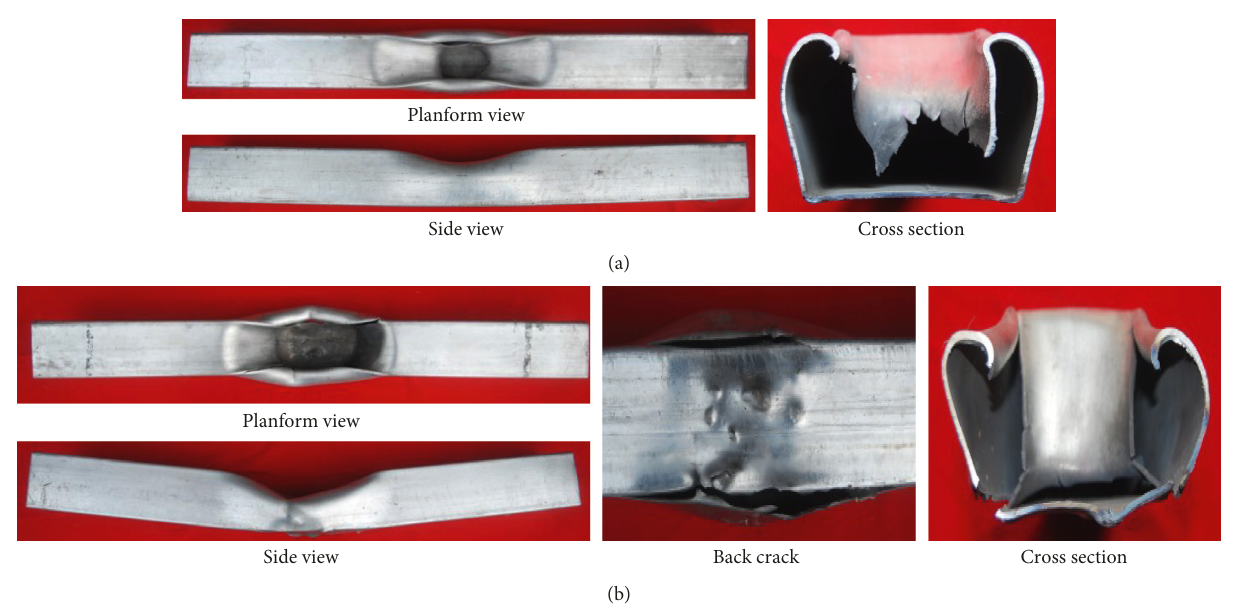
Figure 7: Typical failure modes of square tube in Mode III. (a) The crack presents an axial H-type crack (back without penetration) ( a � 3.0mm, R � 16cm, m � 100g + 160g, TZ9). (b) The crack presents an axial H-type crack (back penetration) ( a � 3.0mm, R � 12cm, m � 100g + 160g,